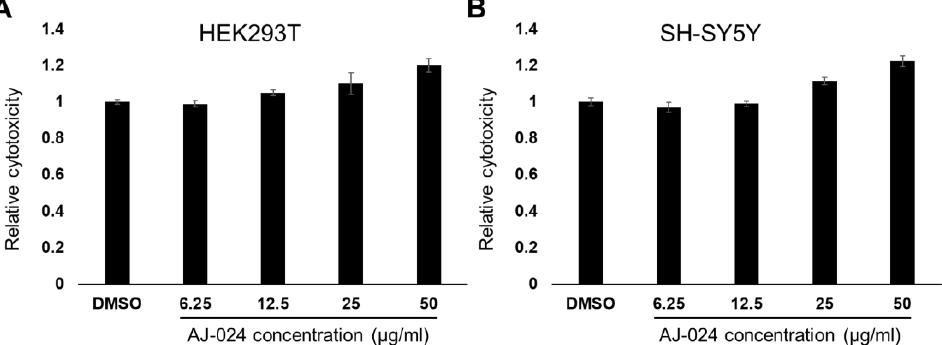
Figure 2. Cytotoxicity assay of AJ-024 on HEK293T ( A ) and SH-SY5Y ( B ) cell. Cytotoxicity was normalized to DMSO control. No toxicity was observable up to 50 µ g/mL of AJ-024.